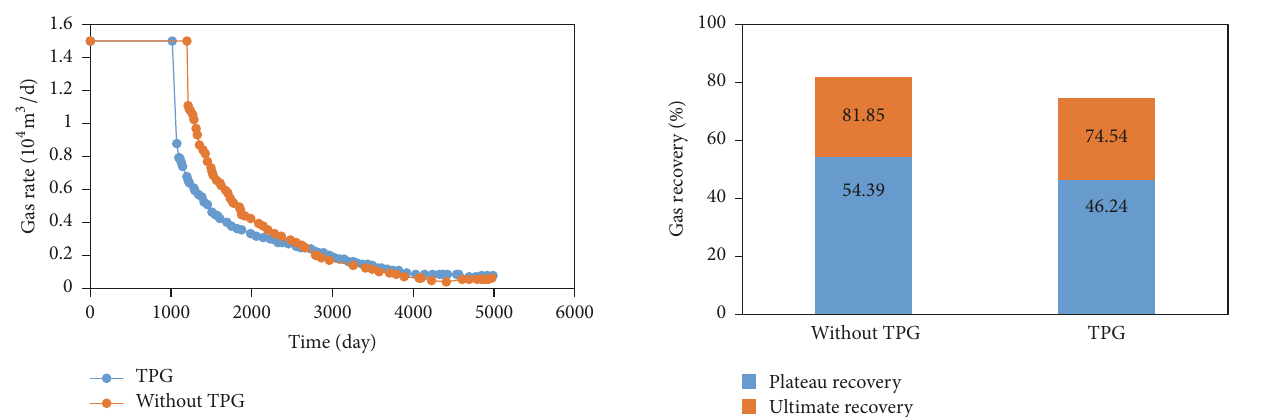
Figure 9: Gas recovery of different periods with or without TPG.